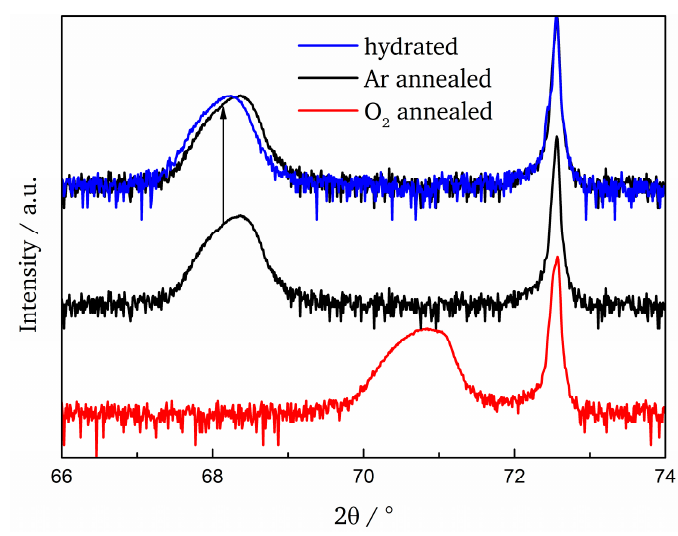
Figure 3. Shift of the (003) reflection due to different sample treatments. To emphasize the change in lattice parameter upon hydration the (003) reflection after Ar annealing is shifted up as indicated.